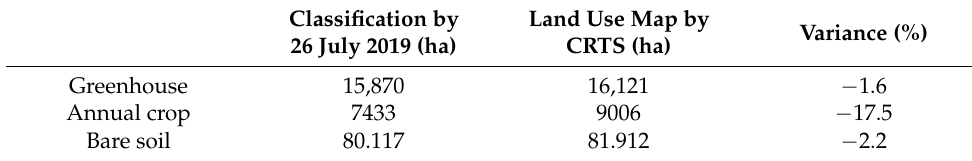
Table 1. Classification results compared to land use map 2019.